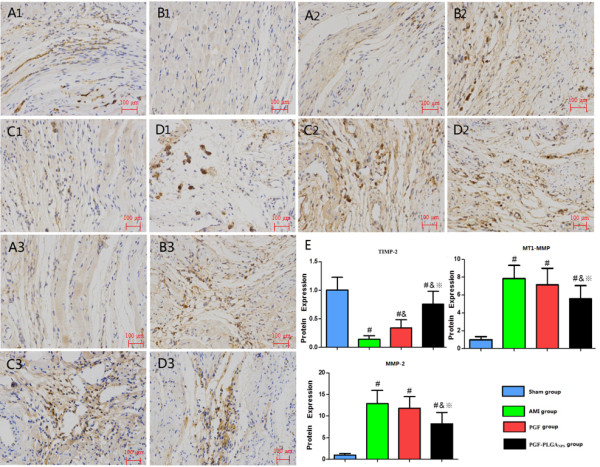
Immunohistochemical signals of TIMP-2 (A1-D1), MT1-MMP (A2-D2), and MMP-2 (A3-D3) (×200) in myocardium in the control group (A), non-treatment AMI group (B), PGF group (C), and PGF-PLGANPs group (D). The densitometric data on the corresponding signals in A, B, C and D are presented as bar graphs in E. Symbols indicate significant differences (P < 0.05) from the control group (#), from the non-treatment AMI group (&), and from the nude PGF group (※), respectively.